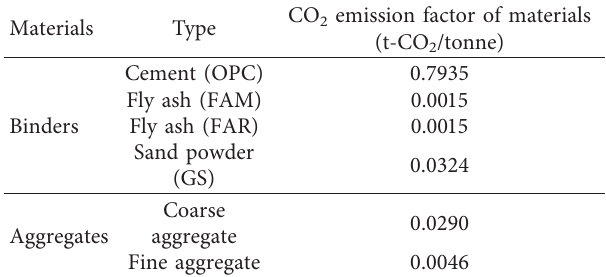
Table 4: Emission inventory data used for CO lation of material production.